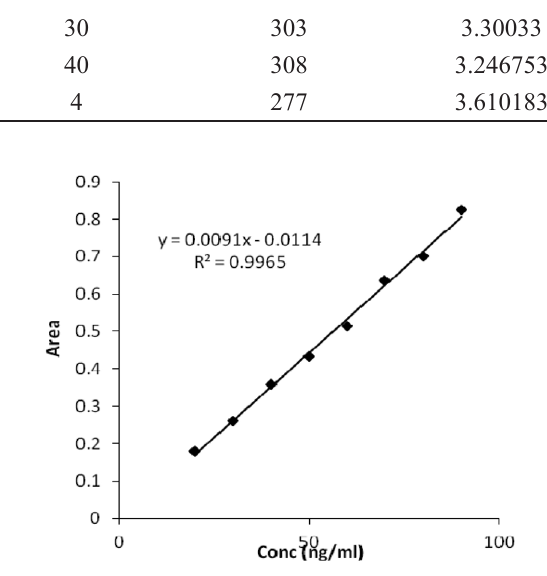
FIGURE 5 - Calibration curve of HP in rat plasma by HPLC method.